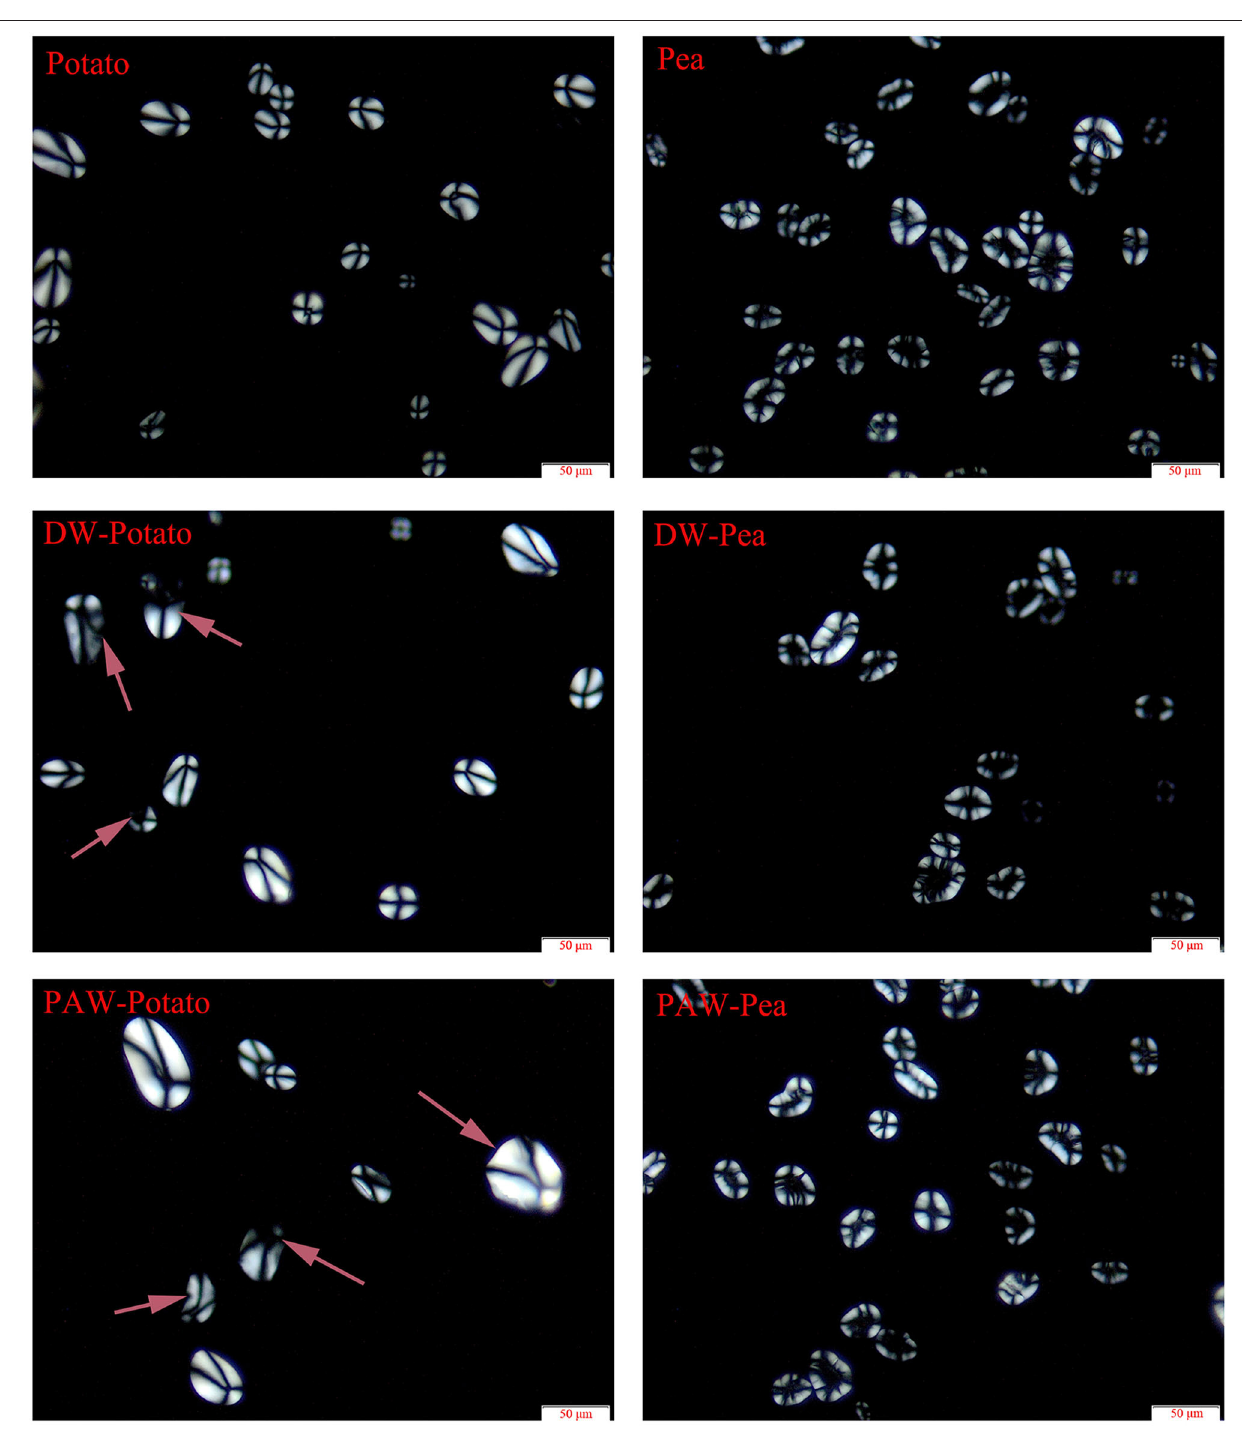
could increase the sensitivity of potato starch to acid hydrolysis, resulting in its crystal structure being more easily hydrolyzed (15). The characteristic diffraction peaks of pea starch